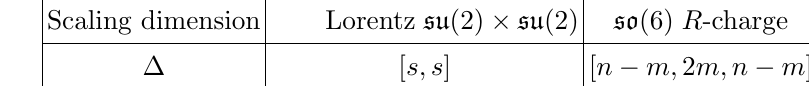
4) Dynkin diagram and Bethe j